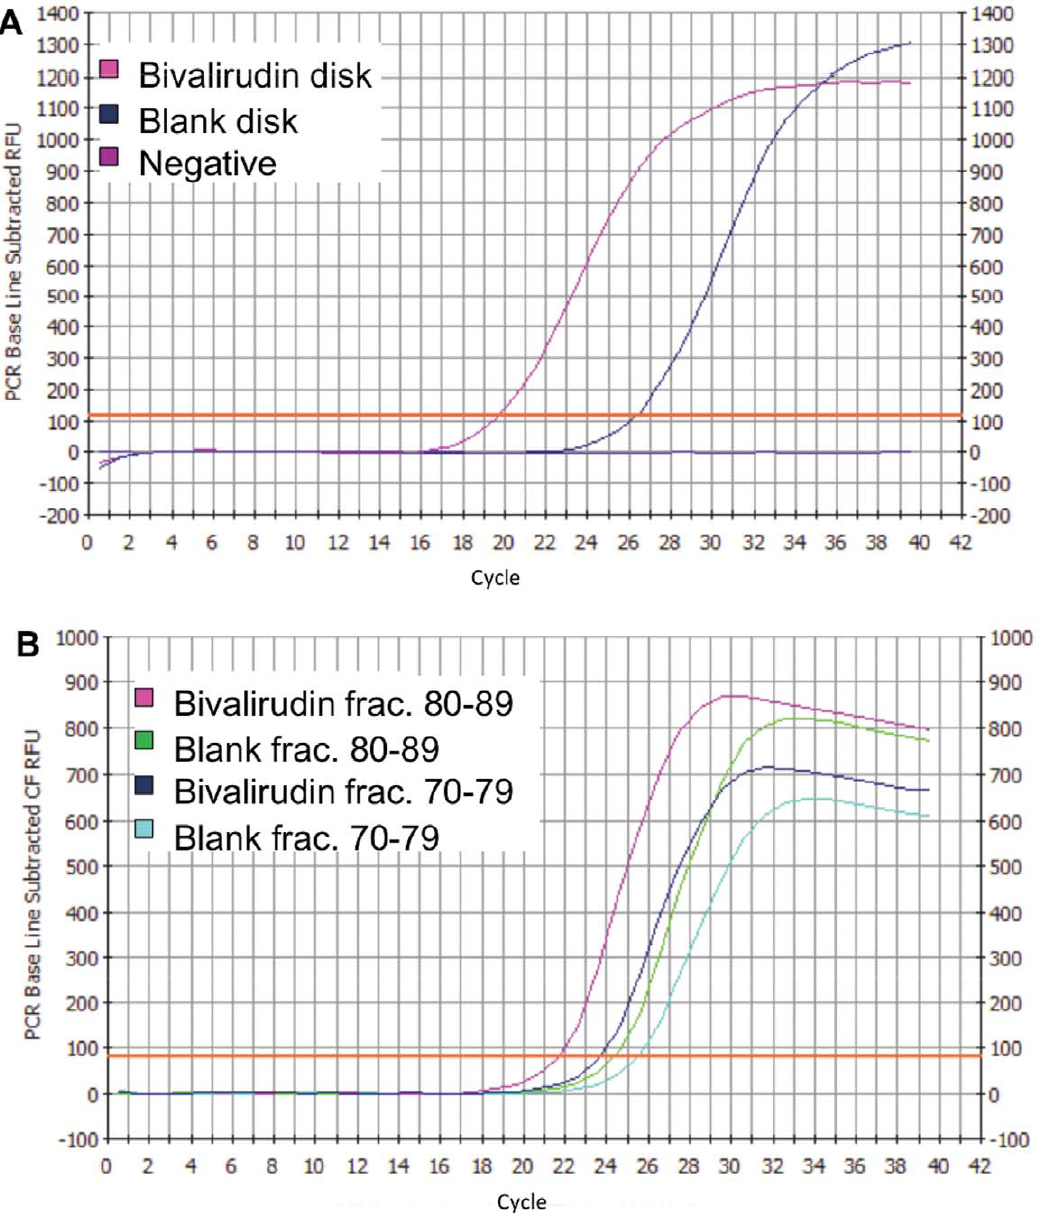
Figure 1. Real-time PCR analysis of fractions from drug and blank disk. A) Round 1 analysis; B) Round 2 analysis.